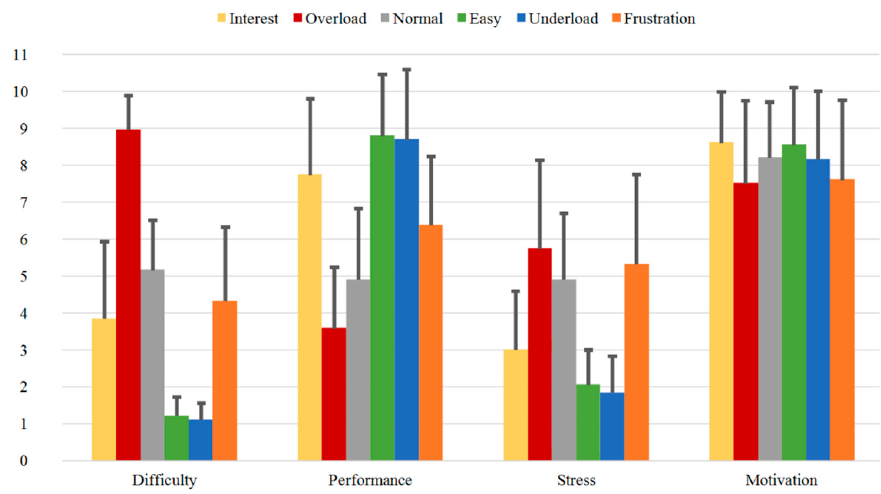
Figure 14. Direct Questions of Group B2 for all the sequences with mean values.